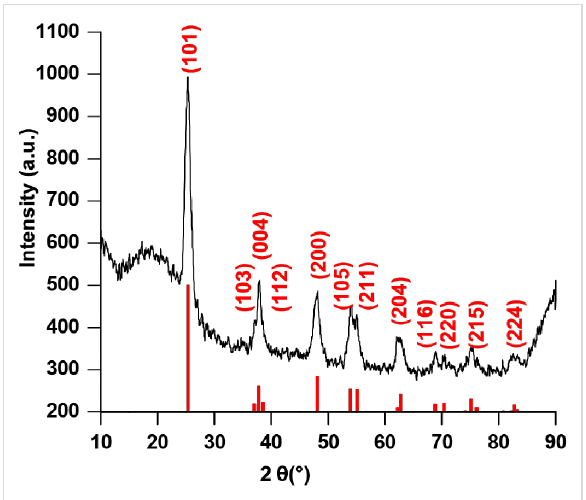
Figure 5: PXRD pattern of carbon-coated TiO 2 particles.